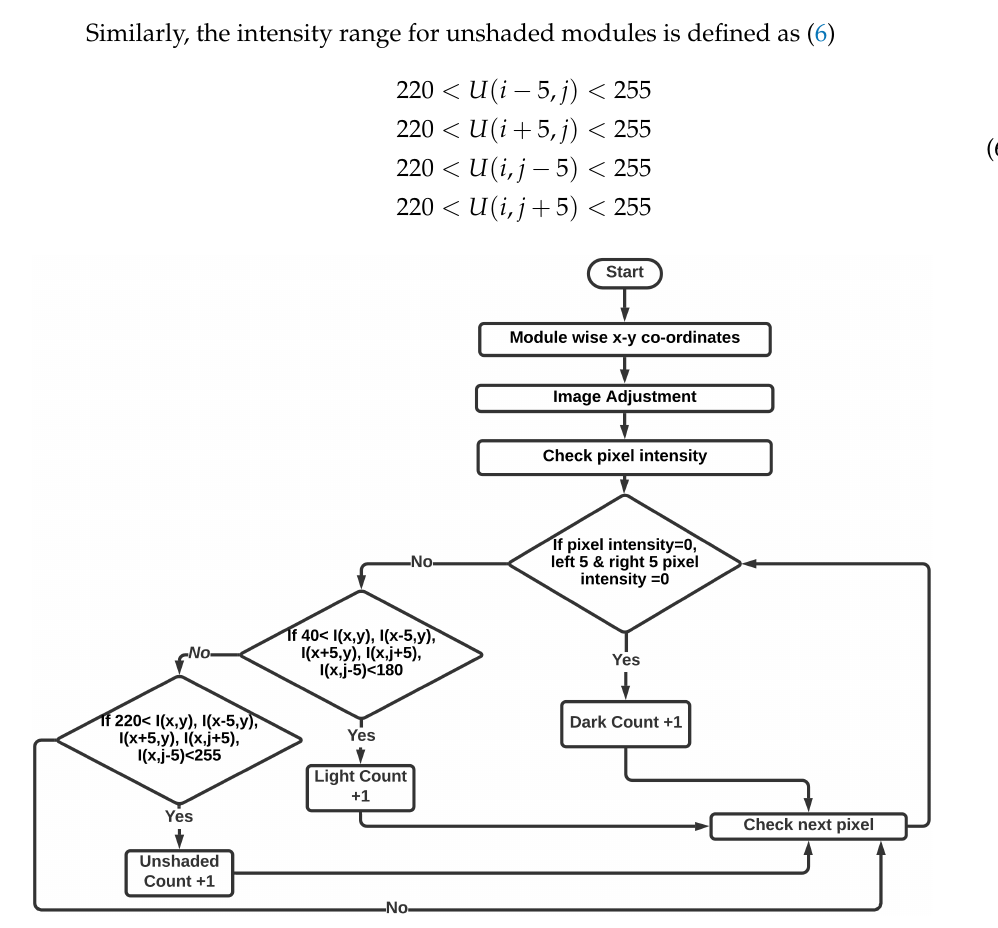
Figure 4. Flowchart of the proposed image processing